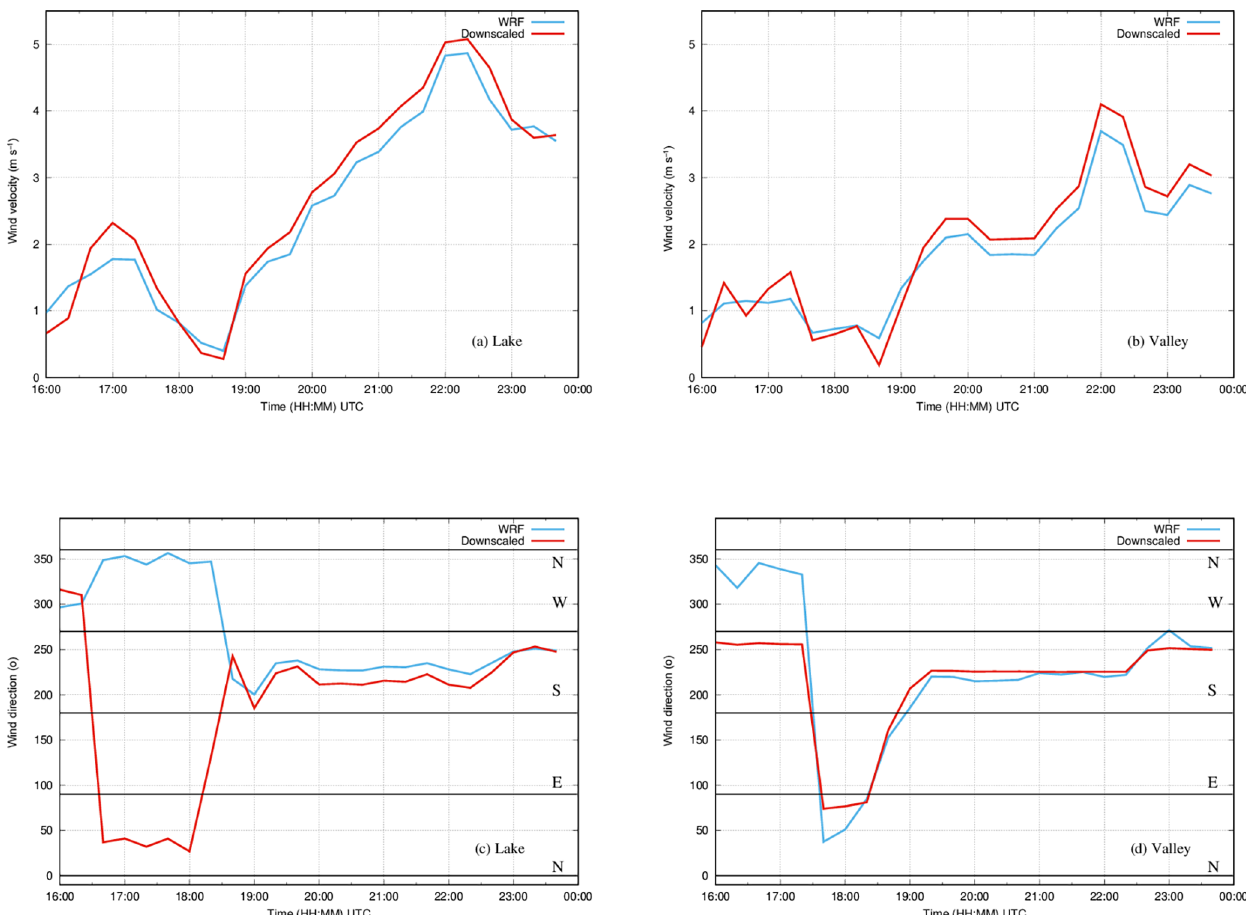
Figure 11. Time series of 10m wind speed and direction at two points located at the Nyos Lake (a, c) and at the bottom of the Nyos valley (b, d) . Results from WRF simulations at 1km resolution (blue lines) and downscaling using ALYA-CFDWind at 50m (red lines). Wind direction criterion is that of the coming direction; i.e. 0 ◦ indicates wind coming from the N, 90 ◦ coming from the E. Note the sudden short-lived wind veering from NE to SW starting at around 18:00UTC.